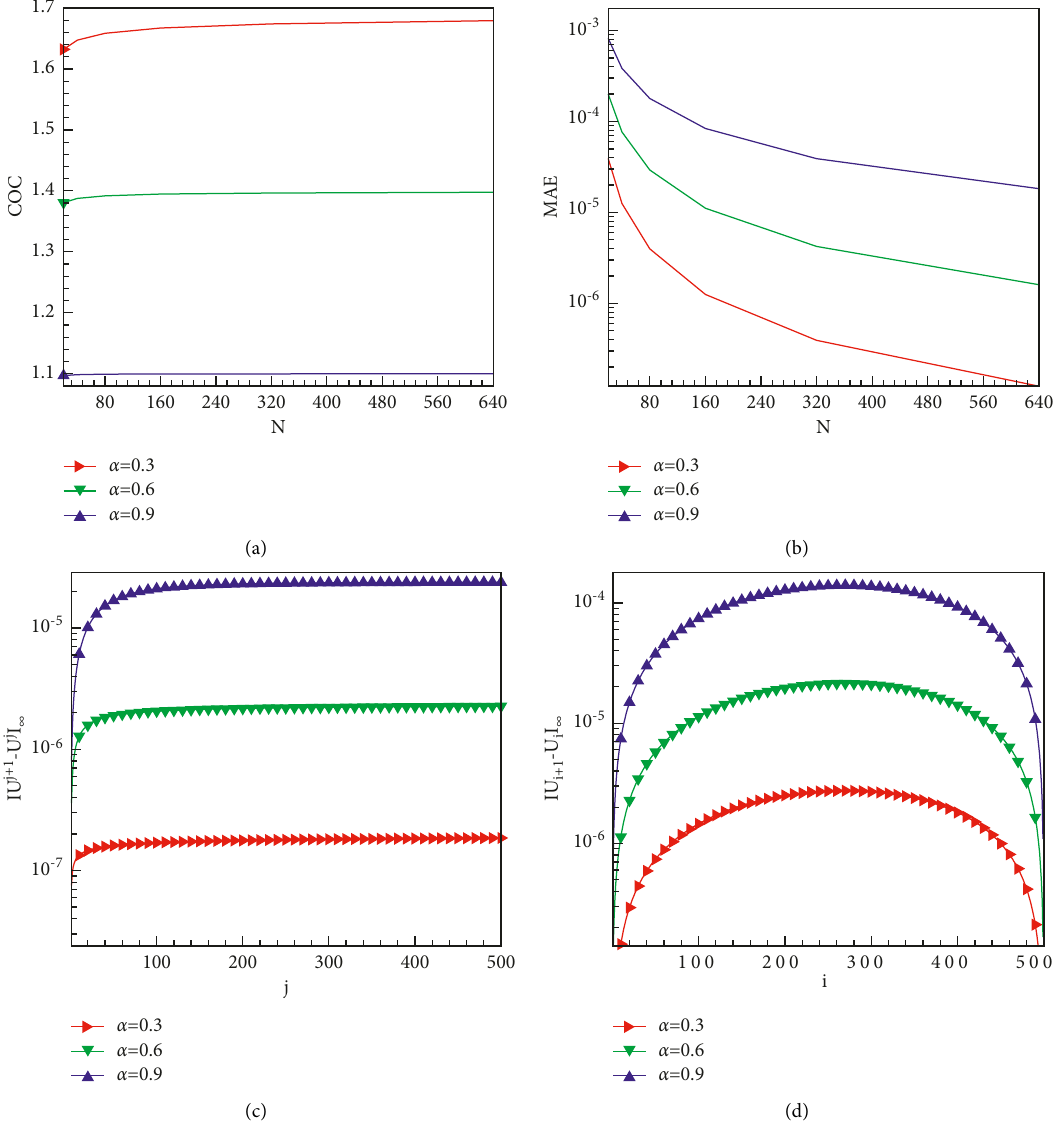
Figure 2: Code validation of the proposed scheme and varying time mesh sizes against (a) computational order of convergence (COC) and (b) maximum absolute error (MAE) and varying mesh sizes for (c) time and (d) space against L ∞ -norm between consecutive